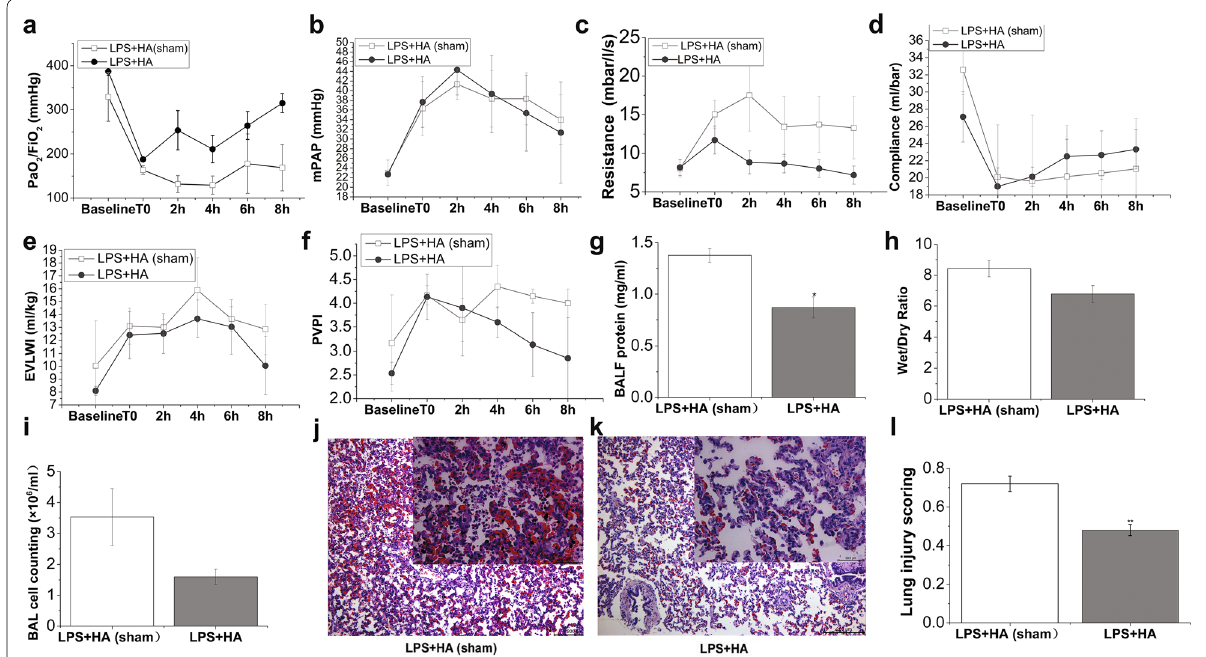
Fig. 3 Effects of HA on oxygenation, lung mechanics and alveolar-capillary barriers. Pigs were challenged with LPS (50 μg/kg) intravenously to recapitulate the features of ARDS. When ARDS was well established (T0), animals received hemoadsorption (HA) or sham-hemoadsorption treat- ment for 3 h. Following another 5-h observation, animals were killed for BALF and lung tissue processing. At baseline, T0, and a series of time points during (2 h) and after HA (or HA-sham) treatment (4, 6 and 8 h), parameters of oxygenation and lung mechanics were recorded. PaO 2 /FiO 2 ( a ) was measured by using blood samples from femoral artery on a blood gas analysis instrument. The value of mPAP ( b ) was gained by Swan-Ganz cath- eter implantation into jugular vein. Resistance ( c ) and compliance ( d ) were recorded by using Drager Evita 4 ventilator. EVLWI ( e ) and PVPI ( f ) were measured by PiCCO system at indicated time points (baseline, T0, 2, 4, 6 and 8 h following HA or HA-sham treatment). BALF protein ( g ) was assessed at 8 h after HA (or HA-sham) as described in “Methods”. h The ratio of wet/dry lung weight of animals in both groups was calculated by gravi- metric method. i Whole-cell counts in the BALF collected from both groups of pigs were numerated by using a counting plate. j and k were the representative lung histology sections of pigs in LPS HA (sham) and LPS HA groups. HE sections are from one representative animal per group. + + l Lung injury scores were calculated according to ATS report which was in detail described in the “Methods.” Data points represent as mean SEM, ± N 3–4 of each group and time point. Statistical significance between HA and HA-sham group per point of measurement is shown as * P < =